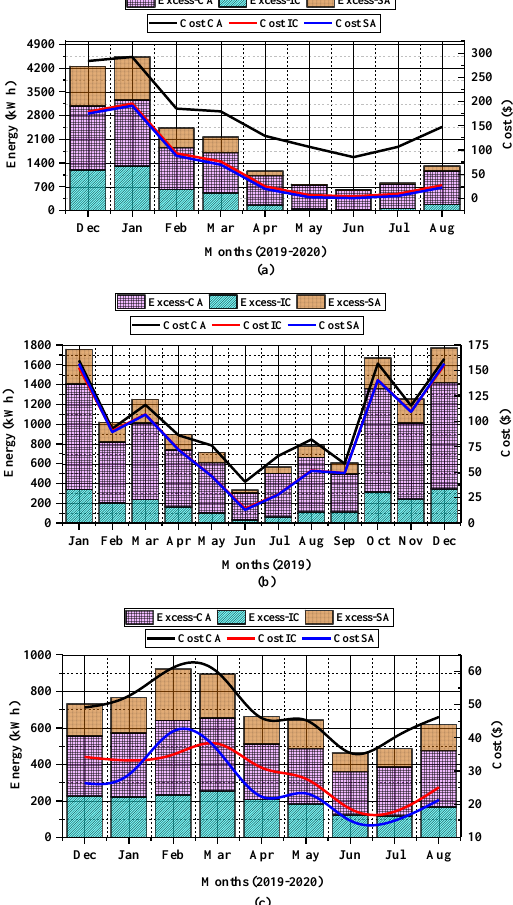
Figure 10. Excess energy gained after implementation of the three strategies and associated cost benefits. ( a ) Evermore, ( b ) Gen Y, and ( c )